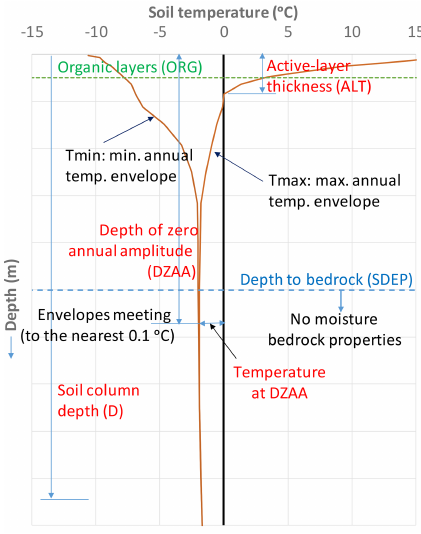
Figure 1. Schematic of the soil column showing the variables used to diagnose